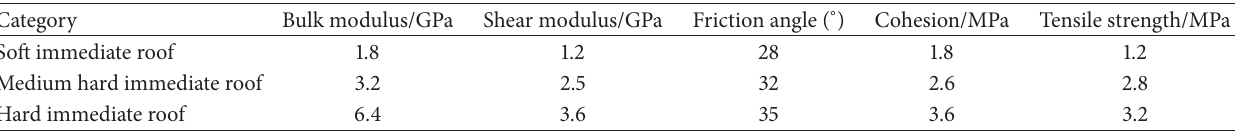
Table 4: Physical and mechanical properties of the immediate roof with different strength.